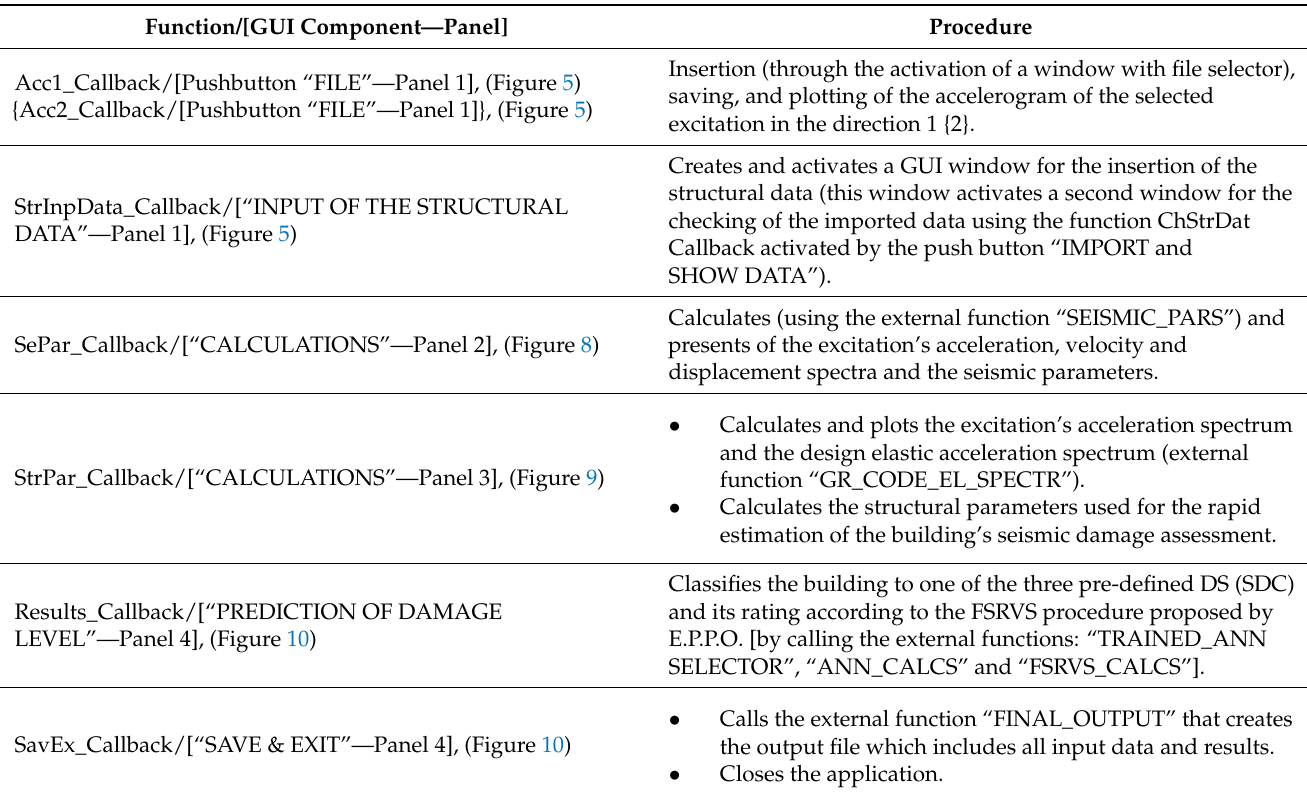
Table 4. Description of the internal functions of application (built-in in the file of the main function).